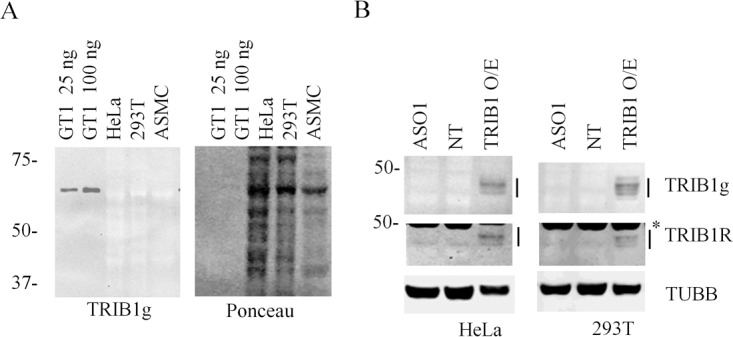
Endogenous TRIB1 is undetectable by straight western blot.A, HeLa, 293T and ASMC lysates were lysed in IP buffer and resolved by SDS-PAGE. Purified GST-TRIB1 fusion (GT1) protein was included as positive control. B, HeLa and 293T cells treated for 48 h with a TRIB1 (ASO1) or a control (NT) antisense oligonucletide were lysed in IP buffer supplemented with protease and phosphatase inhibitor cocktails, resolved by SDS-PAGE and analyzed by western blotting using 2 distinct TRIB1 antibodies. Cell lines stably transduced with TRIB1 and lysed under the same conditions were used as positive control. TRIB1 bands (indicated by side bars) had apparent masses ranging from 43–48 kDa. * indicates residual TUBB signal.